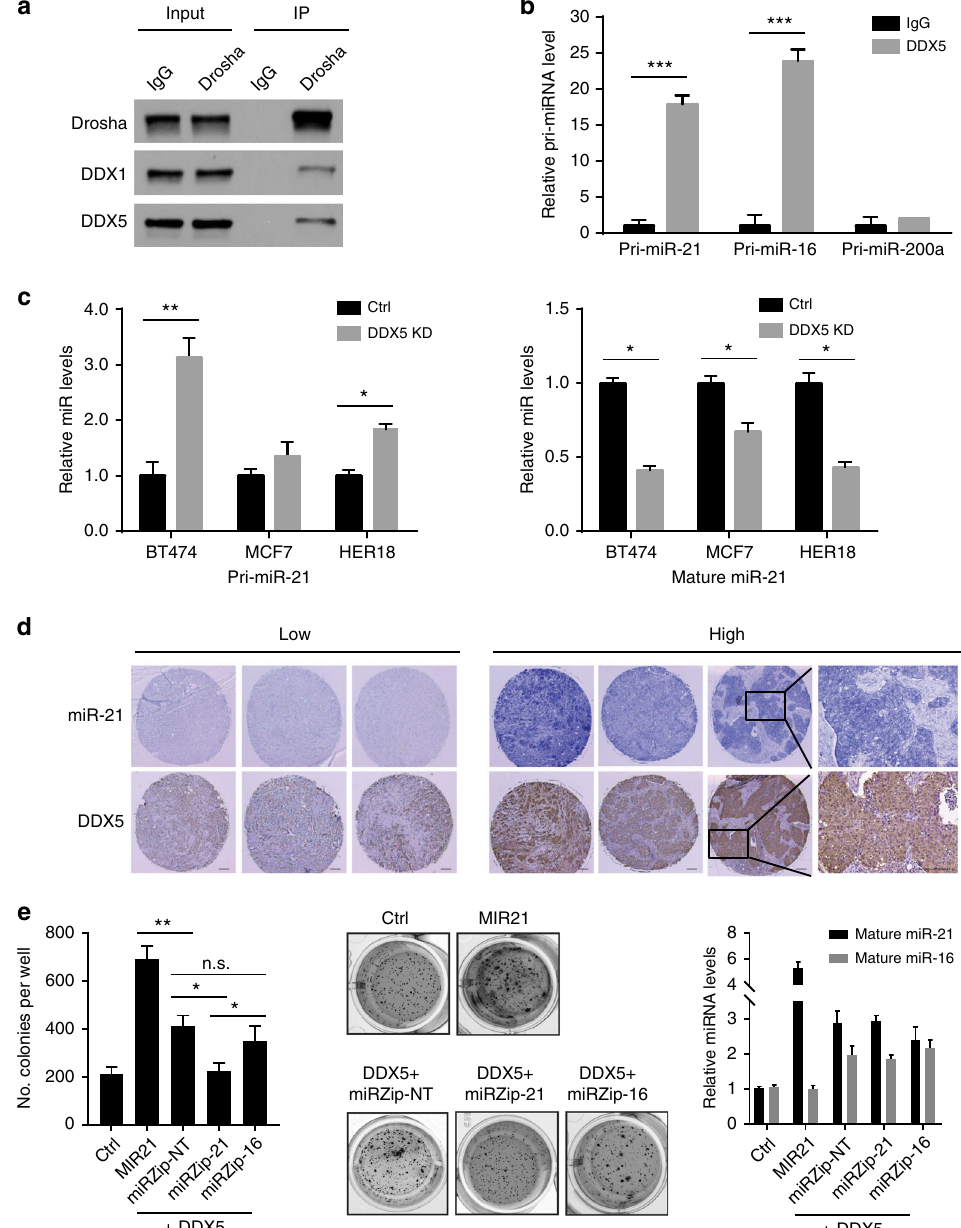
Fig. 4 DDX5 gene is co-ampli fi ed with MIR21 and DDX5 facilitates maturation of pri-miR-21. a Immunoprecipitation (IP) and western blotting analyses were performed using indicated antibodies. Normal immunoglobulin G (IgG) was used as a negative control for IP. The RNA-binding protein DDX1 was used as a positive control for the Drosha-binding proteins. b The DDX5-bound pri-miRNAs were immunoprecipitated with DDX5 and analyzed by qRT-PCR. Control IgG was used as a negative control. c Levels of primary or mature forms of miR-21 were analyzed in control and DDX5-knockdown breast cancer cells harboring 17q23 amplicon. d Levels of mature miR-21 and DDX5 were analyzed in breast tumor samples using in situ hybridization and immunohistochemistry. Representative staining images of tissue samples are shown. Scale bar, 100 μ m. e Soft agar colony formation assays with MMTV-ErbB2 mouse mammary epithelial cells transduced with control vector or lentiviral vector expressing the indicated genes. Representative images are shown in the middle panel and relative expression levels of mature miR-16 or miR-21 are shown in the right panel. * p < 0.05; ** p < 0.01; *** p < 0.001; unpaired 2-tailed t -test ( b , c and e ). Data are presented as mean ± SD and are representative of 3 independent dioxide (CO 2 ) to form chitosan-guanidinium (CG-CO 2 ) in a DPPC, PLGA, and GSK2830371 to form a water-in-oil structure, pH-dependent manner (Fig. 7a) 41 , which may be utilized to where the CG-CO 2 and oligonucleotides were encapsulated in capture/store CO 2 at neutral pH and release at acidic pH. To the aqueous core while PLGA, DPPC, and GSK2830371 were in the surrounding oil. Next, the fi rst emulsion was emulsi fi ed synthesize the nanoparticle, the aqueous solution of CG was with the aqueous solution of PF127-Chitosan (P127 modi fi ed bubbled with CO 2 gas to form CG-CO 2 and then mixed with with chitosan 42 , which served as the stabilizer during the antagomiR21. The aqueous mixture was emulsi fi ed with organic second emulsion). The organic solvent was then evaporated to solvent or oil (dichloromethane: tetrahydrofuran 40:1) containing